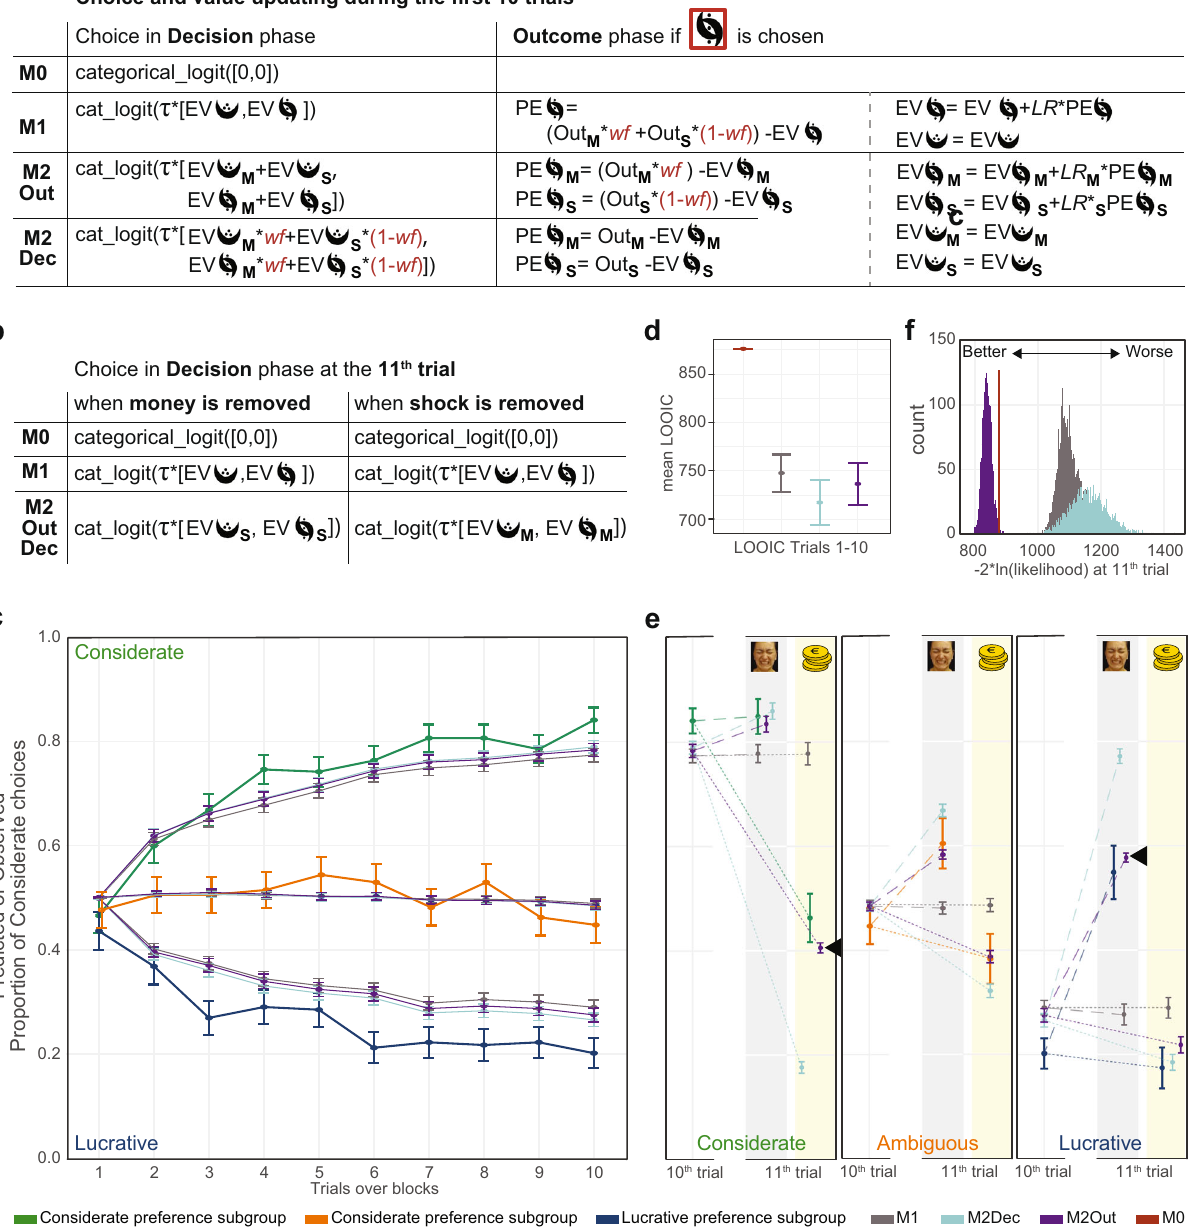
standard error of the estimation LOOICerror. M0 performs poorly, the three learning models perform similarly. The information criterion (IC) scale captures how much information is lost when comparing model predictions with actual choices, and smaller IC thus characterize models that better describe behavior. N =79. e Changeofparticipantchoices( N =29Considerate, N =24Lucrative, N =26 Ambiguous) and model predictions for the 10th to the 11th trial. Dashed lines connect10thto11thtrialswhenmoneyisremoved(graybackground),dottedlines, when shocks are removed (yellow background). 11th trial not included in model fi tting.M2Out(blackarrowheads)makesthebestpredictionsforthe11thtrial.Error bars: standard error of the mean across participants. f Distribution over 4000 posterior draws of the summed log-likelihood of the 11th trial over all participants multiplied by − 2 to place values on the information criterion scale as for LOOIC. M2Out outperformed all other models. We use LOOIC in d , because these fi rst 10 trials were included in the fi tting of the model, but log-likelihood in f because it is not included in the model fi t. Source data are provided as a Source Data fi